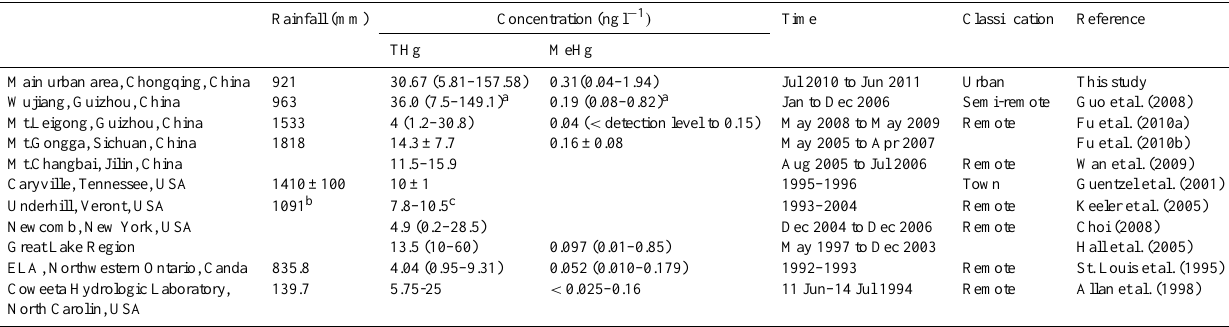
Table 2. Comparison of THg and MeHg concentration in precipitation measured in Core urban area, Chongqing, China and those at other